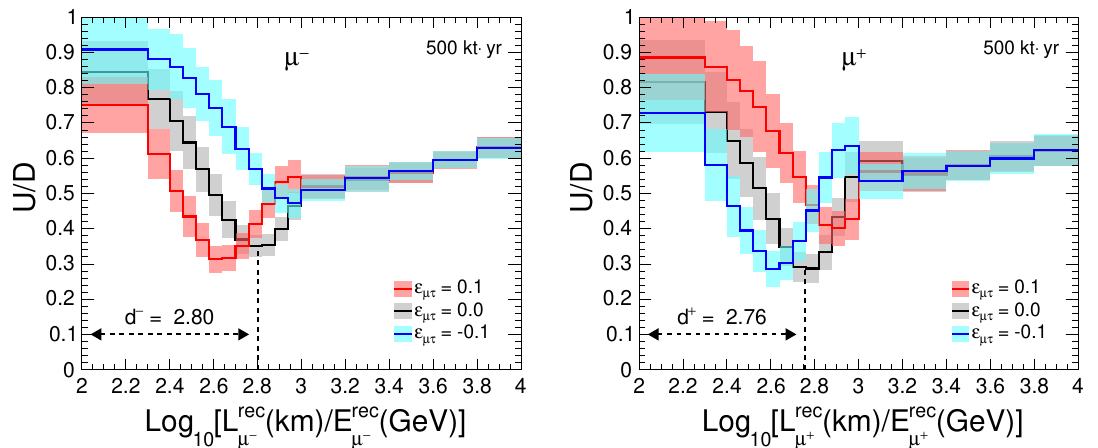
( L rec ) distributions of ratio of upward-going and downward-going µ − Figure 5 . The log /E rec 10 µ µ (left panel) and µ + (right panel) events using 10-year data of ICAL. The black lines correspond to SI ( ε = 0 ), whereas red and blue lines are for ε = 0 . 1 and -0.1, respectively. The statis- µτ µτ tical fluctuations shown by shaded boxes are the root-mean-square deviation of 100 independent distributions of U/D ratio, each for 10 years, whereas the mean of these distributions are shown by solid lines. We consider normal mass ordering, and the benchmark oscillation parameters given